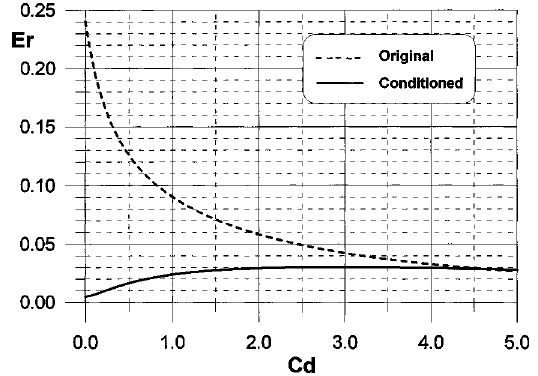
Fig. 16. Residual error function for variations of the non-linear spring constant D n